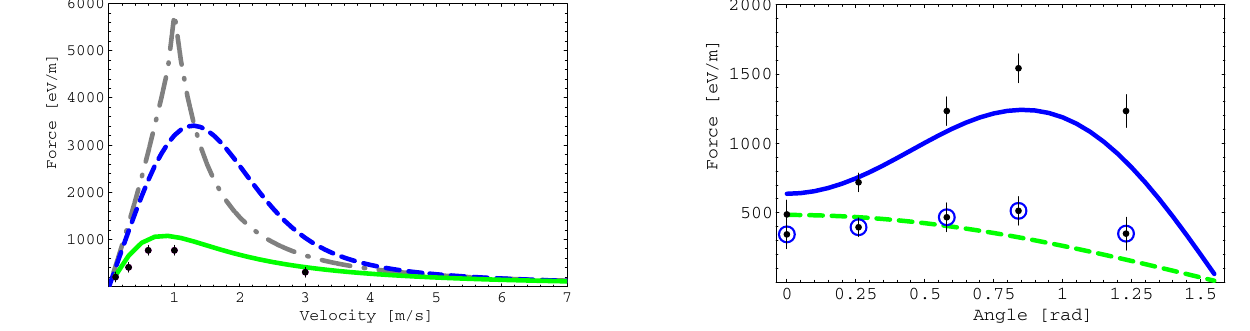
FIG. 3. (Color) Longitudinal component of the force: solid blue line—Eq. (5); dashed green line—Eq. (9); pink dots with error bars— VORPAL results for ‘‘cold’’ electrons; open circles with error bars— VORPAL results for finite-temperature electrons.